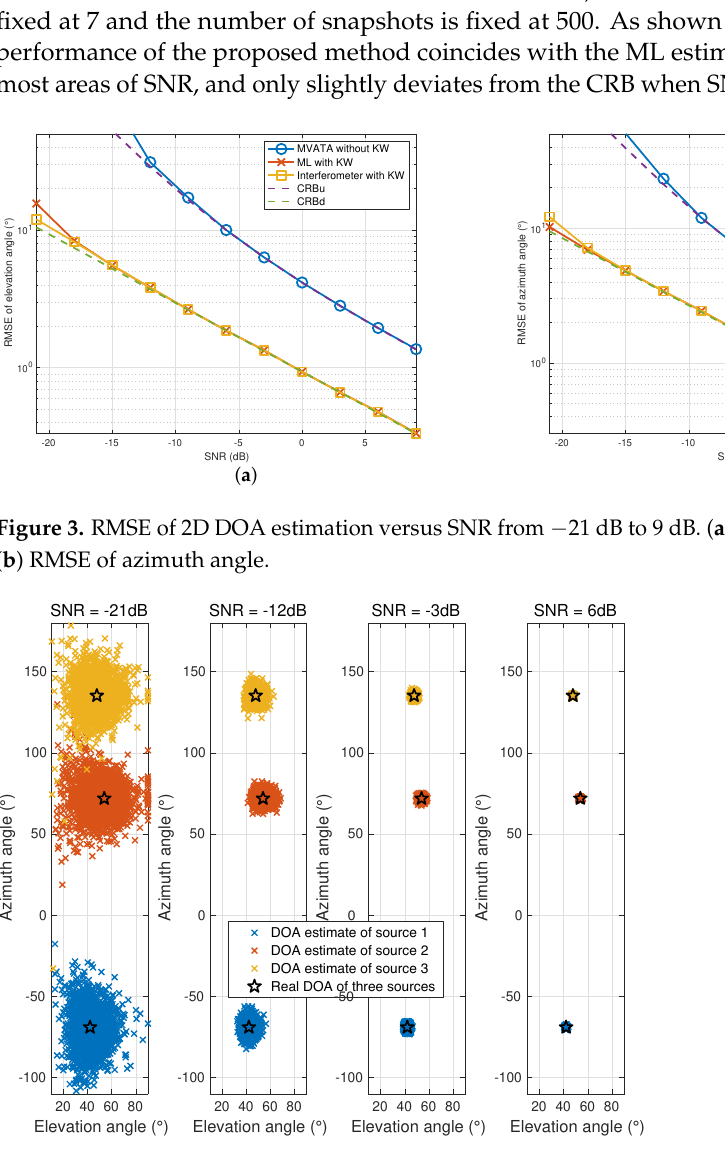
Figure 4. Scatter plot of 2D DOA estimates of the proposed